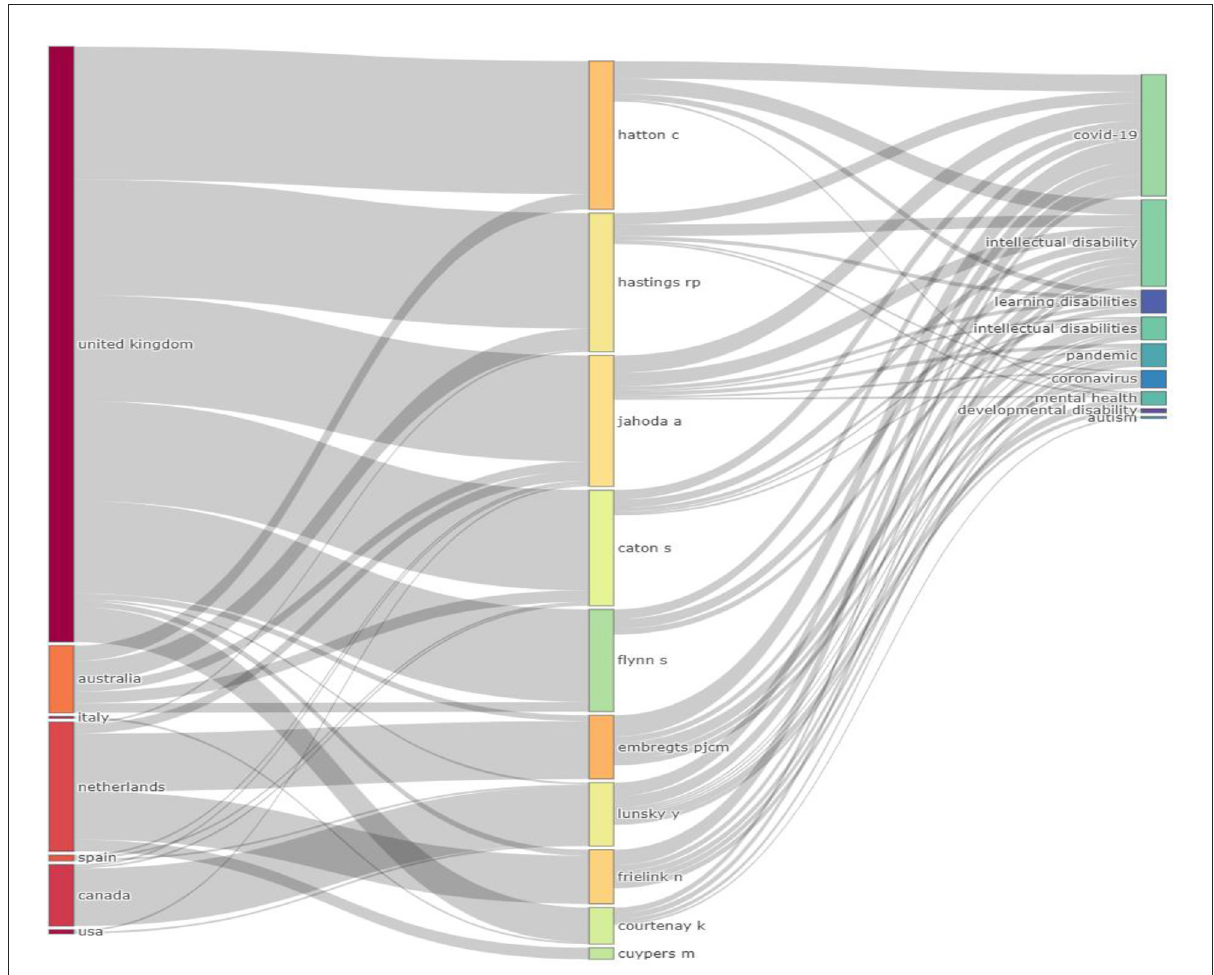
FIGURE1 Three-field plot showing the association among countries, authors, and keywords. The left field shows the countries, the middle field the authors and the right field the authors’ keywords.